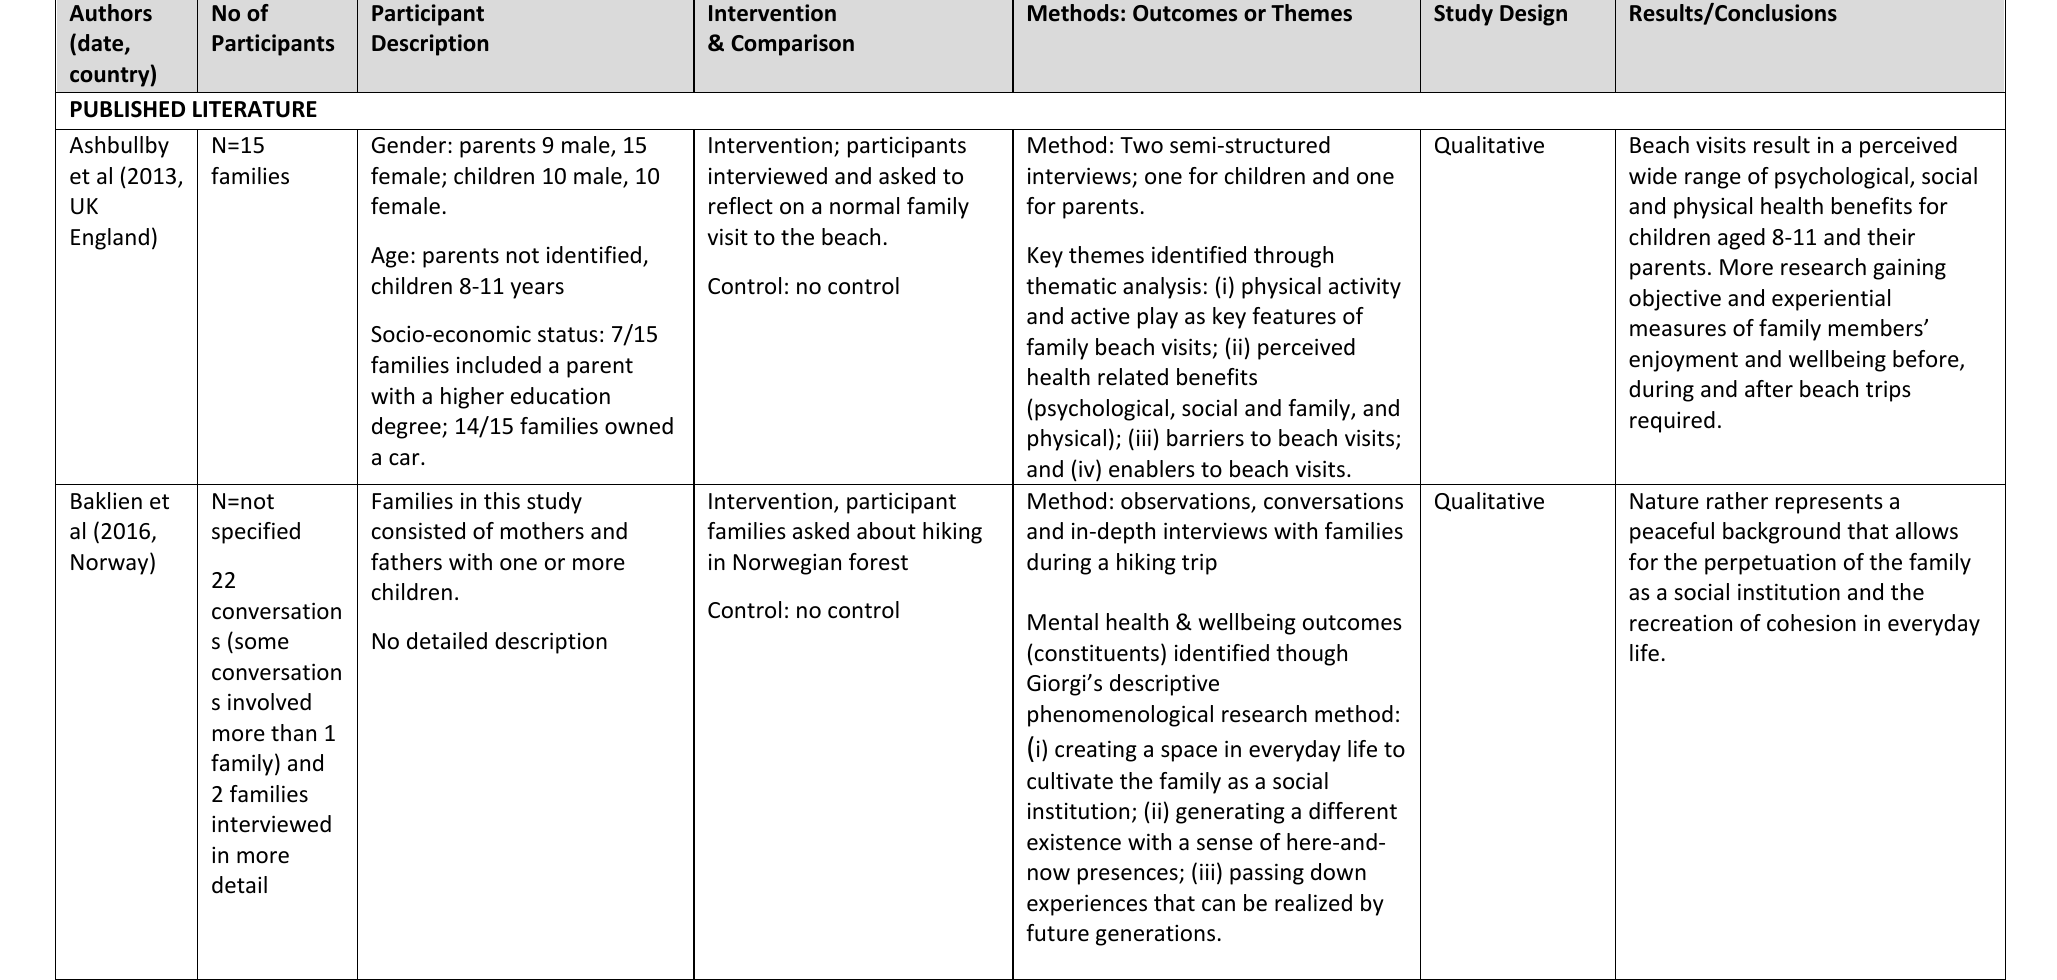
Table 4 Characteristics of included studies (published studies and grey literature on healthy outdoor recreation, families and